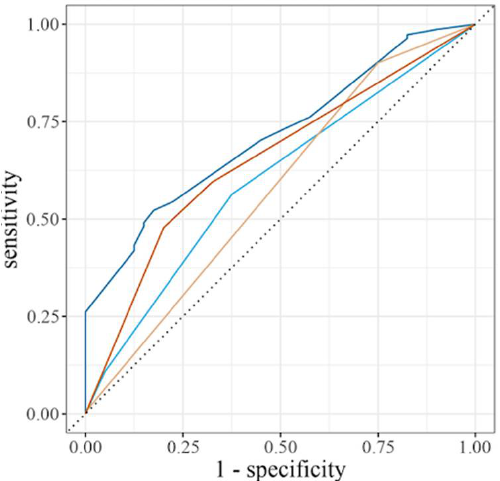
Figure 1. Receiver operator characteristic (ROC) curves of individual SNPs from TGF (rs1800469, AUC 60%, light blue line), IL6R (rs8192284, AUC 65%, red line), and TLR4 (rs4986791, AUC 58%, yellow line), and all three SNPs (AUC 71%, dark blue line) to predict GWI.